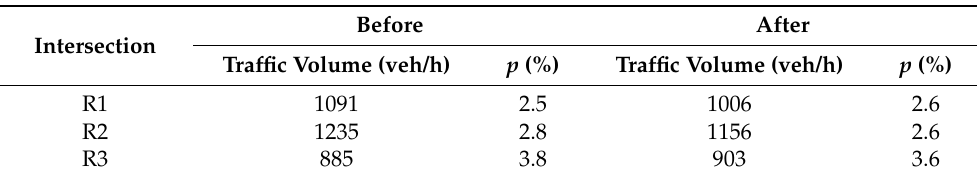
Table 2. Hourly traffic volume and truck proportion at the intersections detected during noise load measurements in Michalovce City.